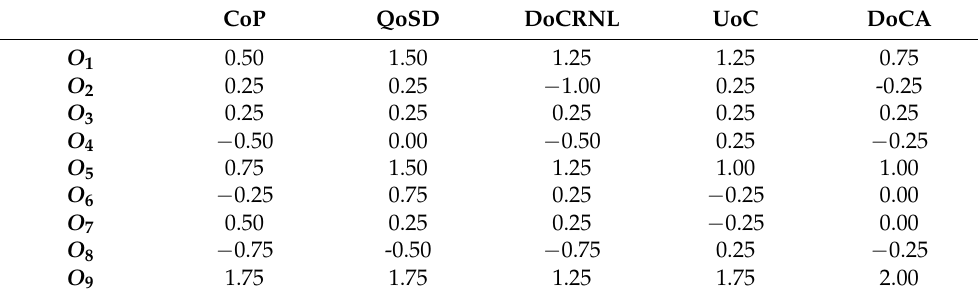
Table 24. Score values for PLTS ELECTRE II.